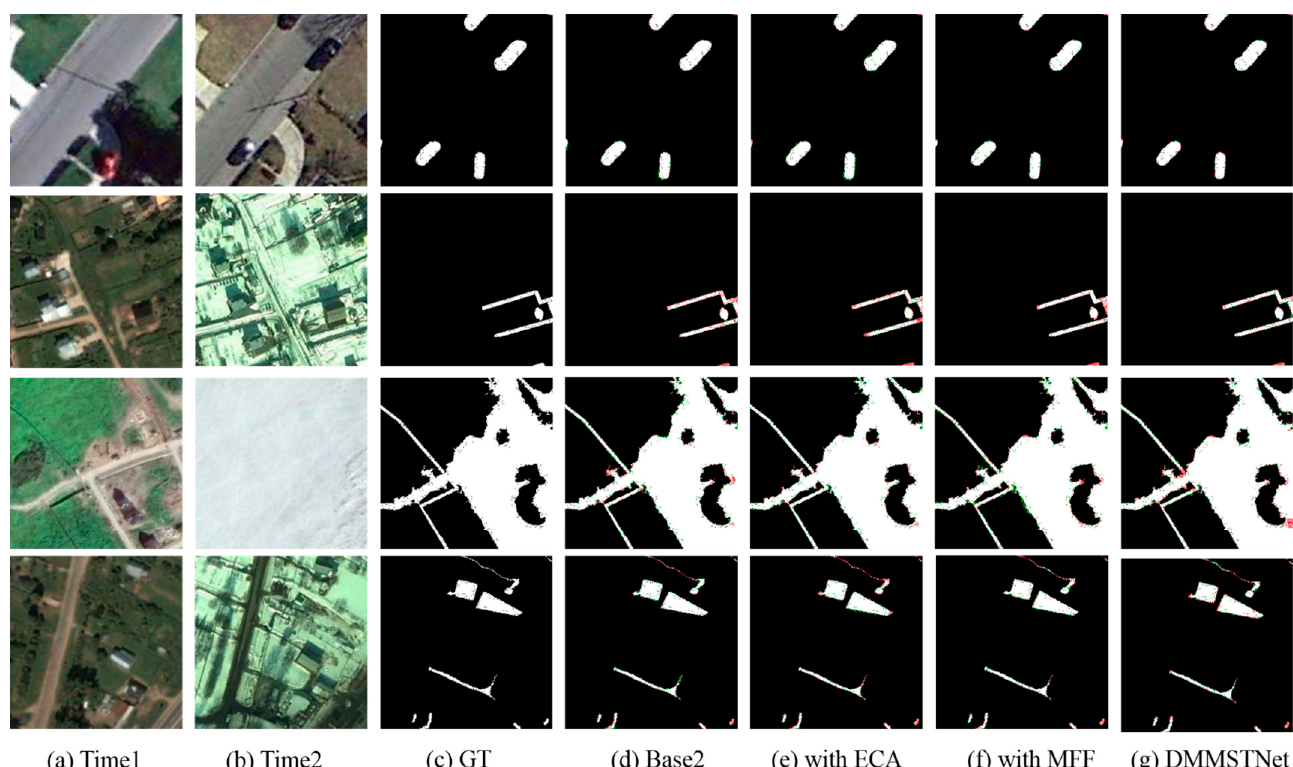
Figure 13. Ablation Base2 experimental results on the CCD dataset. ( a ) The images at time1. ( b ) The images at time2. ( c ) The ground truth. ( d ) The results of Base2. ( e ) The results of “Base2 + ECA”. ( f ) The results of “Base2 + MFF”. ( g ) The results of DMMSTNet. Table 6. Numerical Ablation Base2 Results on CCD Dataset.